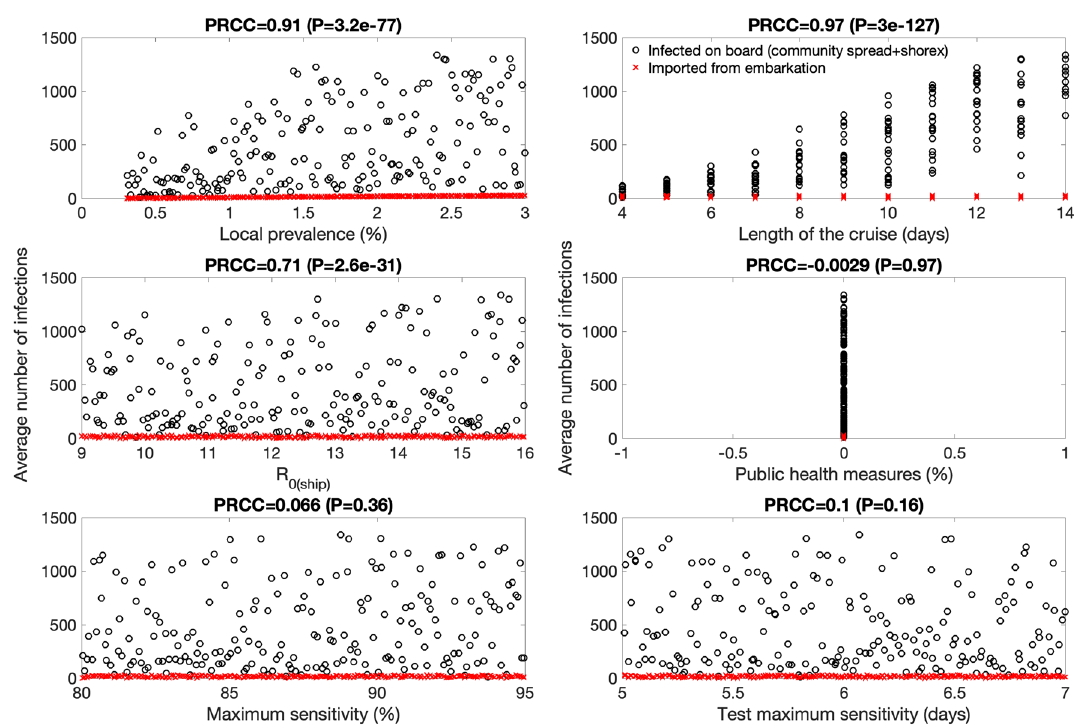
Figure 7. These scatter plots display the relationship between the model parameters and the average number of infections in the absence of testing strategies and public health measures. Partial rank correlation coefficients (PRCC) and their statistical significance (P value) after considering the uncertainty ranges for each parameter (Table 1) are also shown. Local prevalence and the length of the cruise are strongly and positively correlated with the expected number of cases at the end of the simulations. The basic reproduction number aboard the ship is also correlated with the average number of